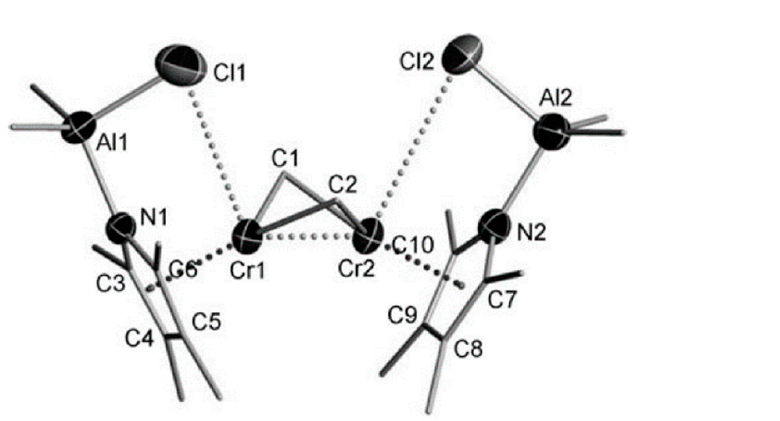
Figure 28. Molecular structures of complex Cr04 . Reprinted with permission from [236]. Copyright (2009) Wiley-VCH Verlag GmbH & Co.